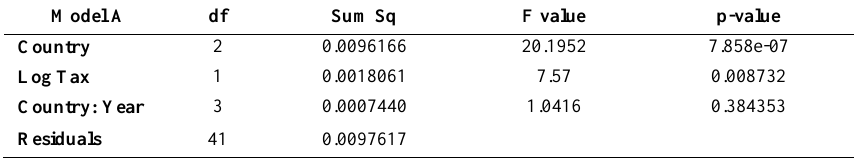
Table 3. Results for Model